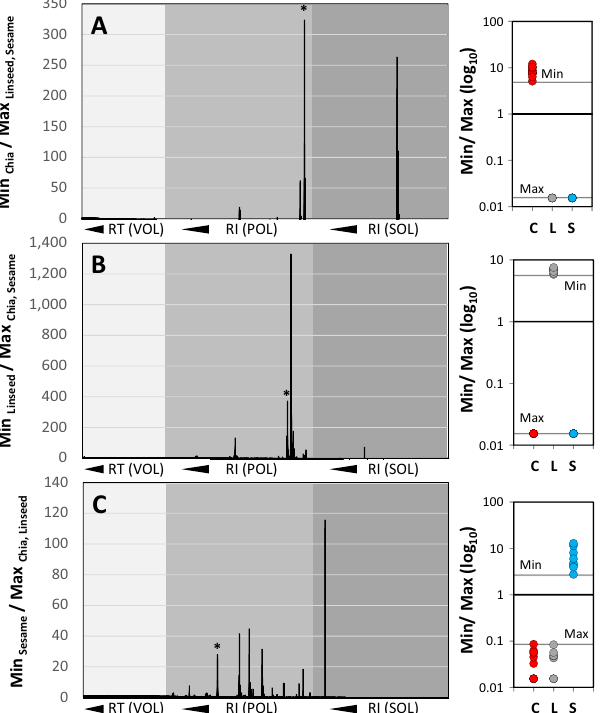
Figure 4. Minimum over Maximum ratios of mass feature abundance distributions from non-targeted metabolite profiles of three chemical fractions from chia, linseed and sesame seeds. Ratios of minimum (Min) abundances of mass features observed in one seed type over the maximum (Max) abundance in the other seed types are plotted left to right according to retention time (RT) of the VOC analysis (light grey underlay) or according to retention index (RI) of POL (middle grey) and SOL (dark grey) profiles, ( A ) Min Chia /Max Linseed, Sesame , ( B ) Min Linseed /Max Chia, Sesame , and ( C ) Min Sesame /Max Chia, Linseed . Inserts to the right illustrate exemplary abundance distributions using the mass features that are indicated by a star ( * ) to the left. Note that the plotted Min/Max ratios represent a measure of the gap between non-overlapping abundance distributions. Missing values were substituted before ratio-calculations by an estimate of the detection